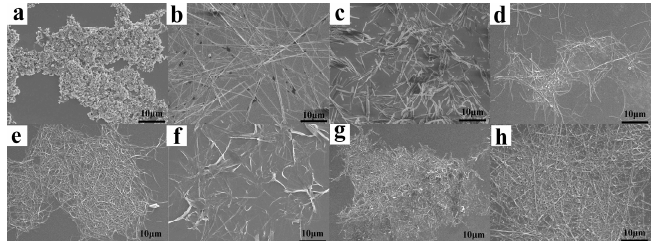
Figure 7. Scanning electron microscopy (SEM) images of PBI-1 aggregates assembled in various organic acids, r = 5000:1. ( a ) No added acid, ( b ) p-toluenesulfonic acid, ( c ) oxalic acid, ( d ) malonic acid, ( e ) citric acid, ( f ) formic acid, ( g ) glutaric acid and ( h ) acetic acid.